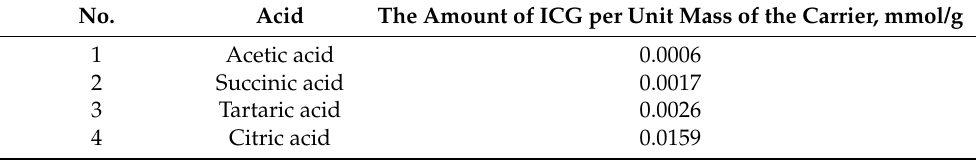
Table 4. Chitosan coating capacitance by